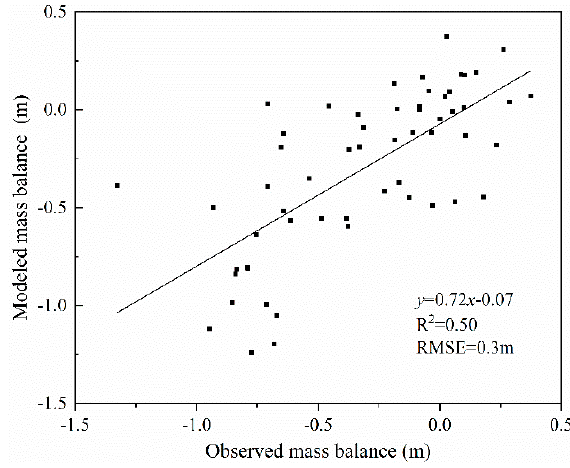
Figure 3. Correlation between modeled mass balance and observed mass balance.